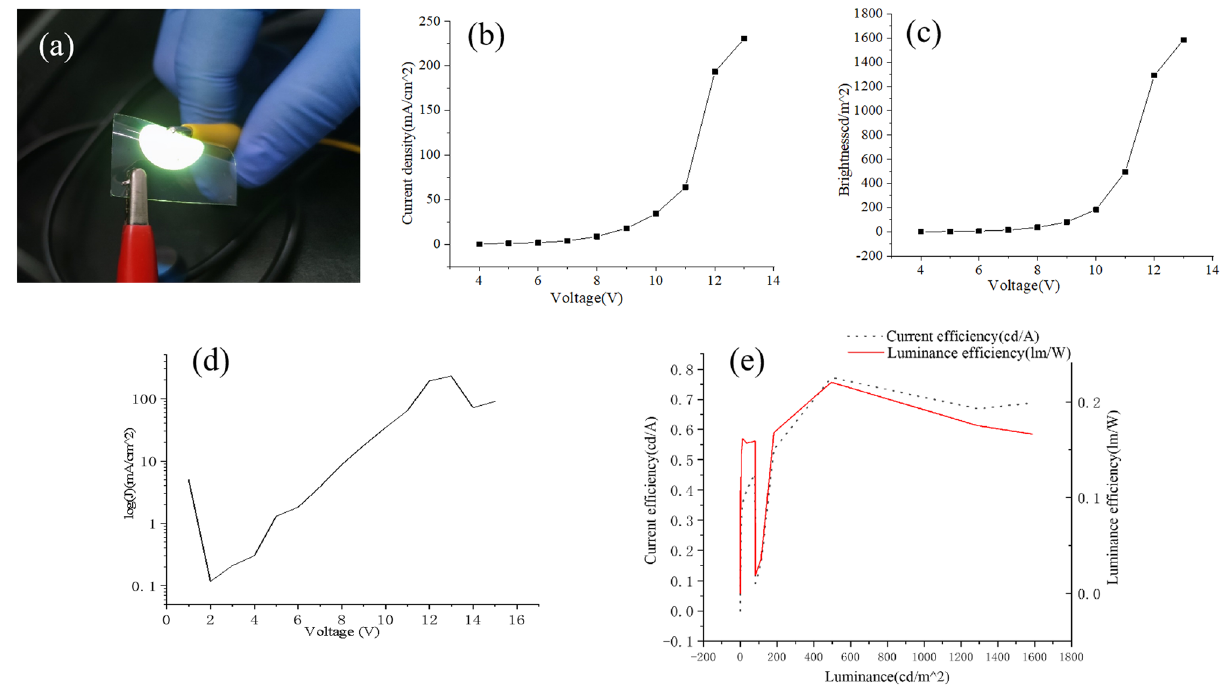
Figure 10. Photoelectric performance of the flexible OLED based on copper network film. ( a ) Luminescence diagram of flexible OLED at 10 V. ( b ) Current density–voltage characteristic of OLED device. ( c ) Brightness- voltage characteristic of the OLED. ( d ) Current density in log scale versus voltage. ( e ) Current efficiency and power efficiency of the